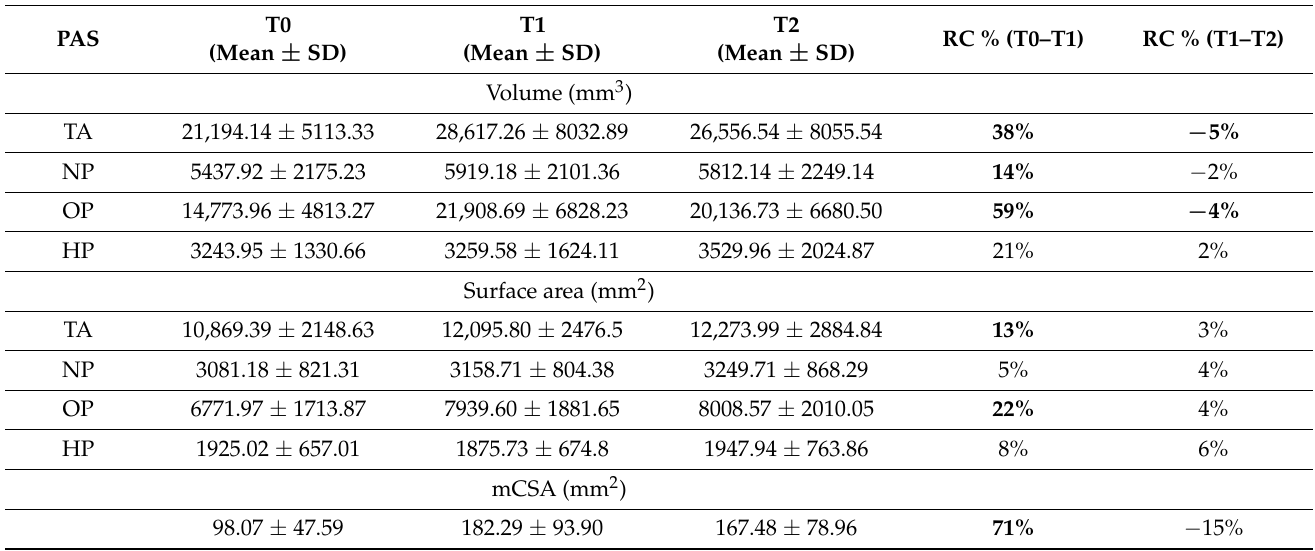
Table 1. Mean ± standard deviation and relative change (RC %) of airway volume, surface area, and minimum cross-sectional area